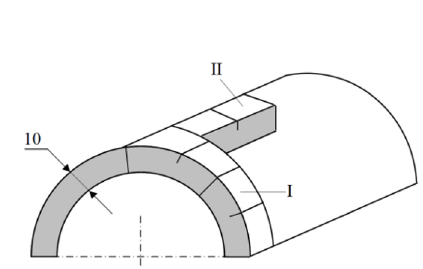
Figure 1. Schemes for specimen cutting and application of concentrators on Charpy specimens